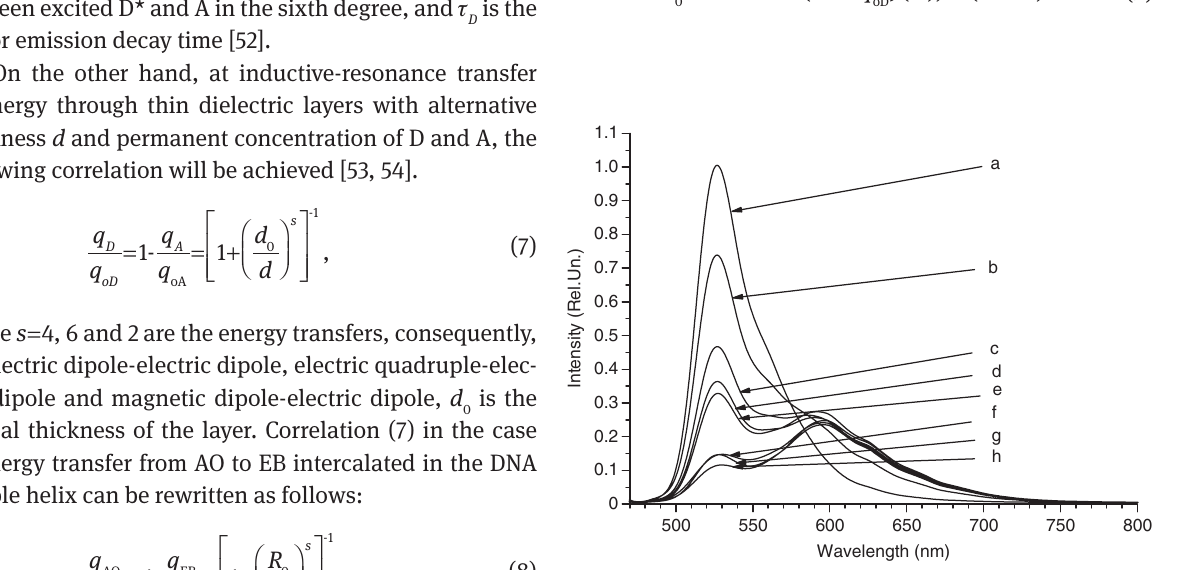
Figure 15 Fluorescence spectra of double and ternary DNA-AO and DNA-AO-EB complexes where concentration of DNA changes the distance between donor AO and acceptor EB. (a) DNA-AO [DNA] – 2.8 × 10 -4 mol/l (P), [AO] – 0.14 × 10 -4 mol/l, [NaNO